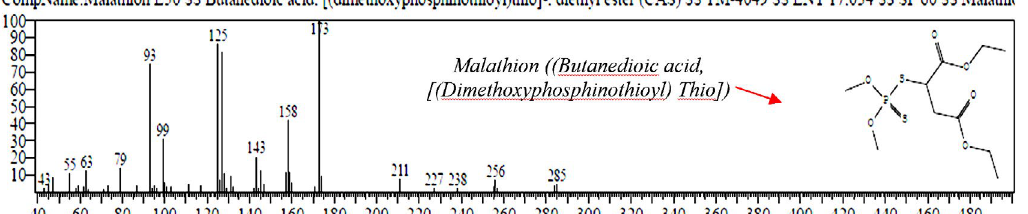
H O PS or Butanedioic acid, 10 19 6 2